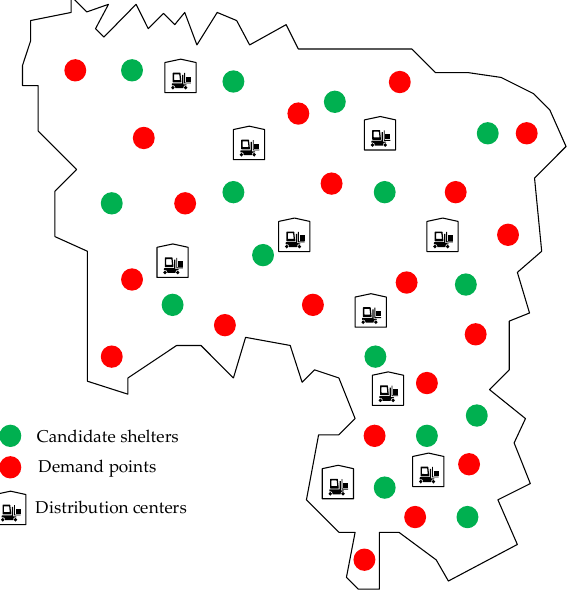
Figure 5. The geographical location of demand points, shelters, and distribution centers.